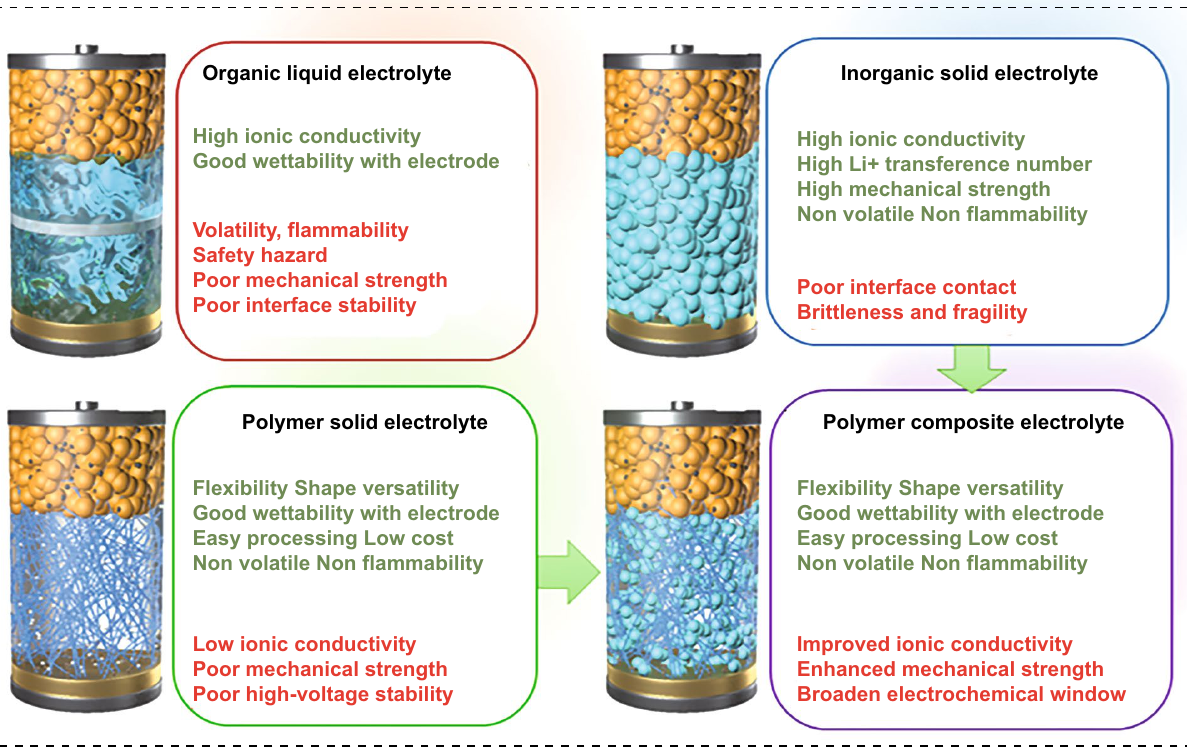
Fig. 1 Performance comparison of different